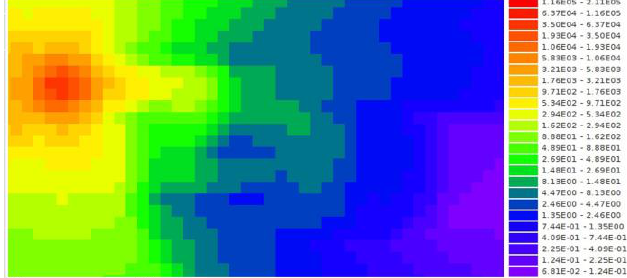
Fig. 5. Total neutron flux - MCNP [par.cm -2 .s -1 ]